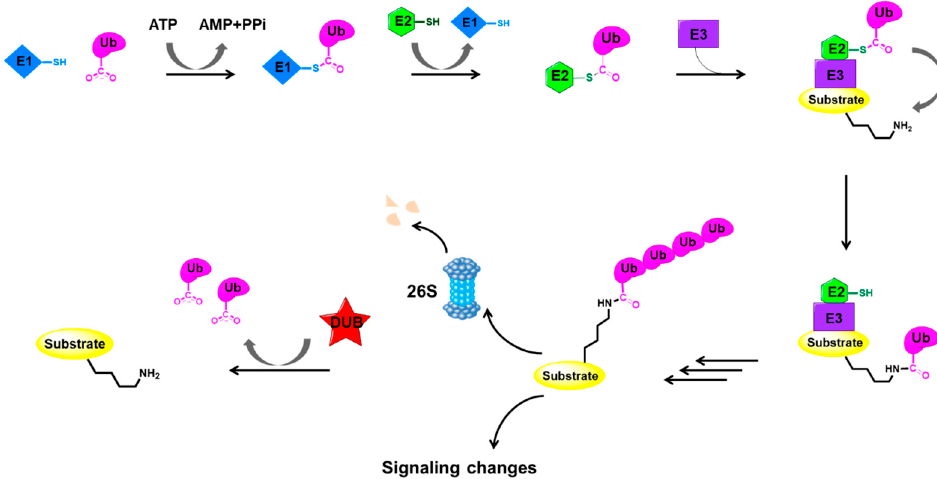
Figure 1. Key events in the ubiquitylation and deubiquitylation process [1–3]. E1: ubiquitin-activating enzyme; E2: ubiquitin-conjugating enzyme; E3: ubiquitin-protein ligase; Ub: ubiquitin. Really interesting new gene (RING) E3 ligases which represent the vast majority of E3 ligases are depicted here as an